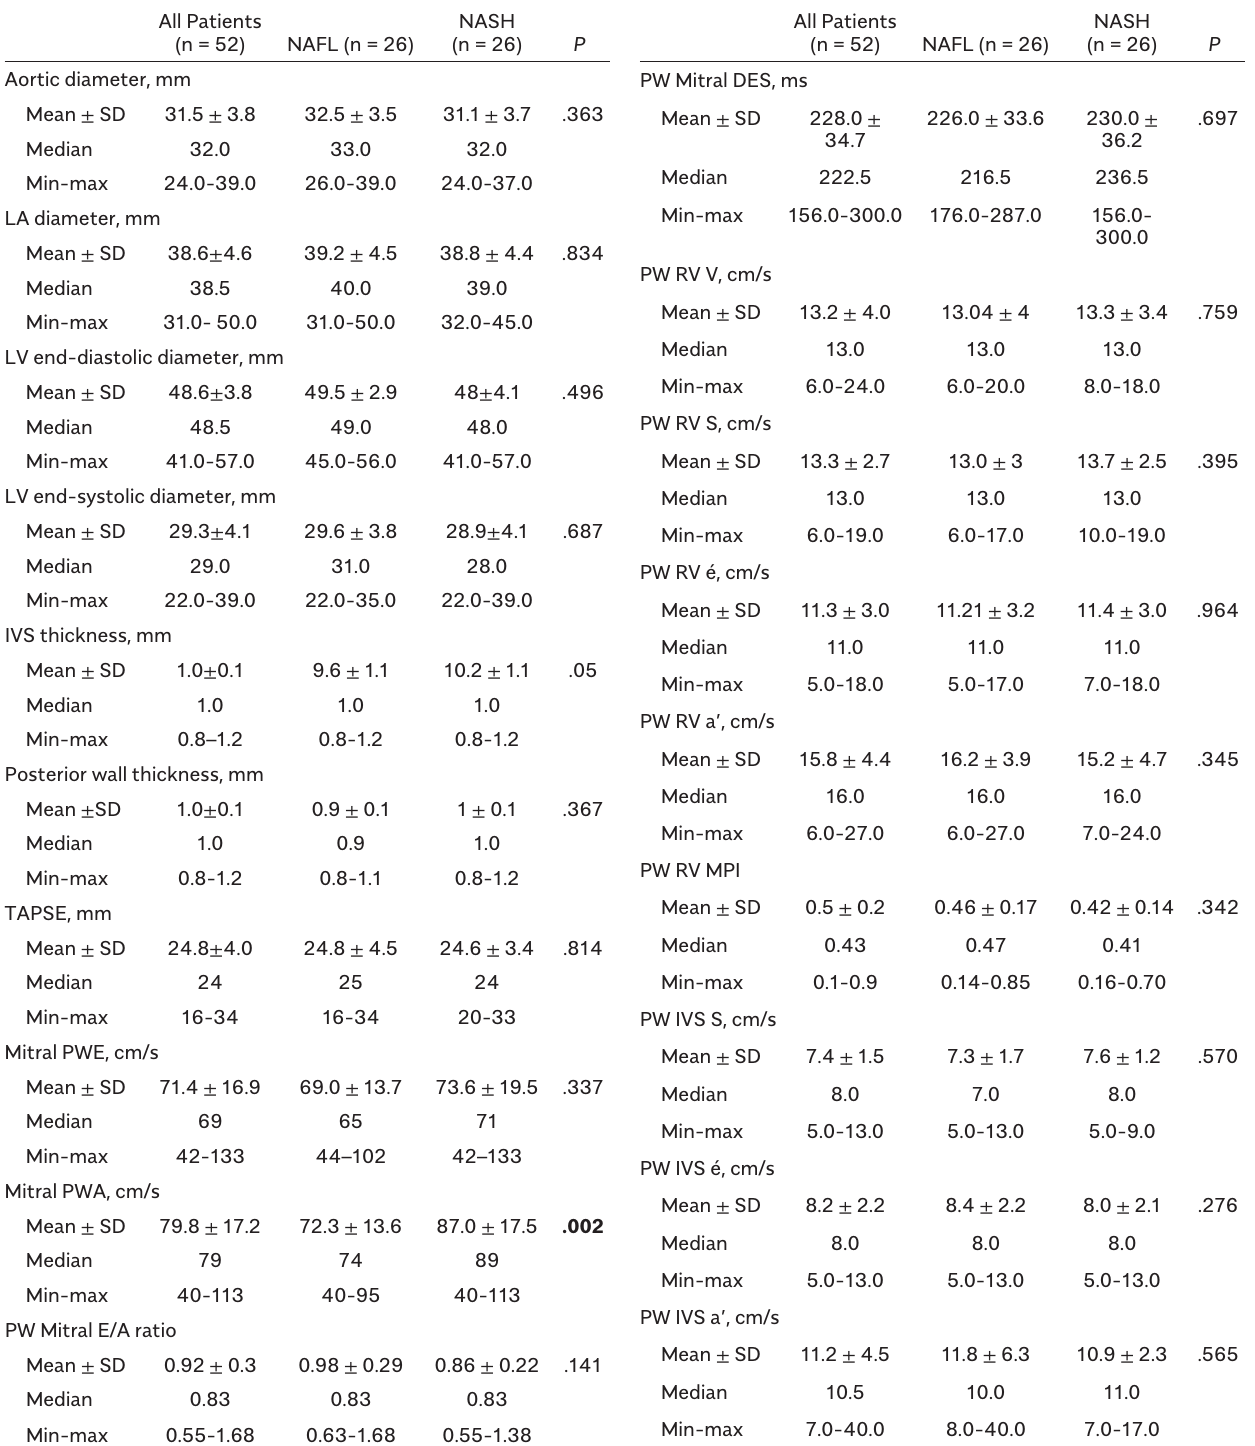
Table 4. Echocardiography and Cardiac MR Assessments of Patients All Patients (n =